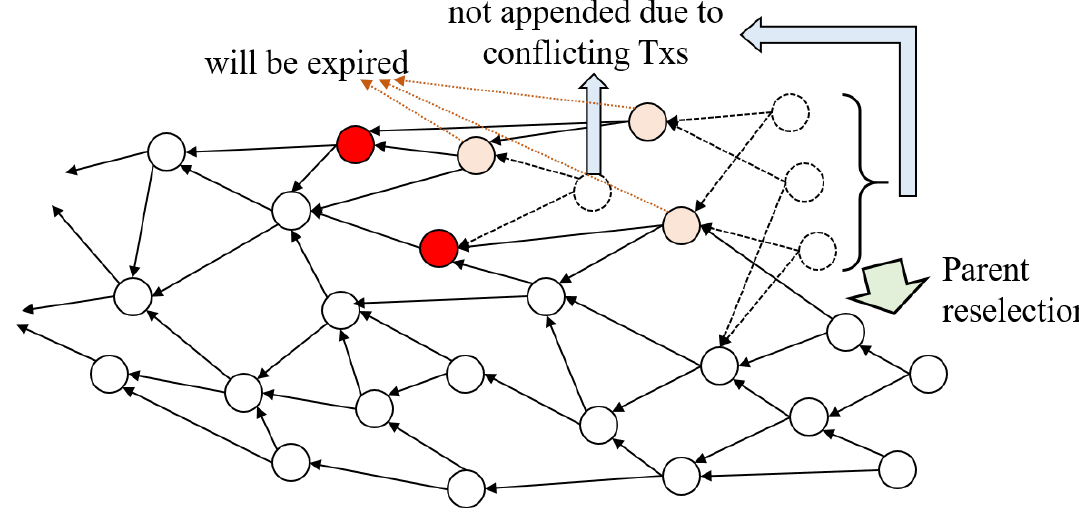
Figure 4. Previous DAG-based DLT